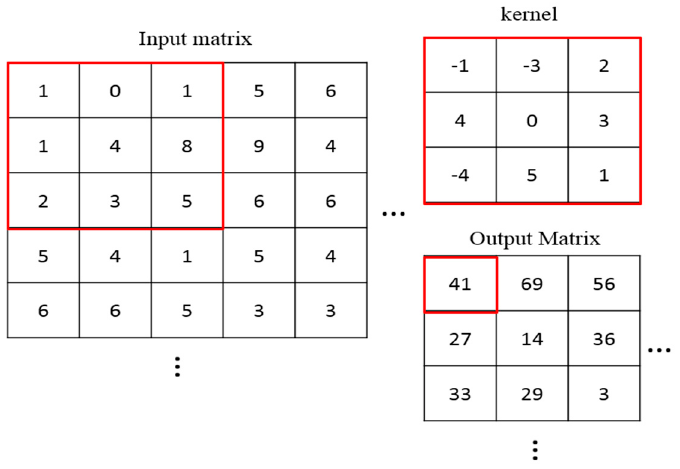
Figure 2. Procedure of convolution.